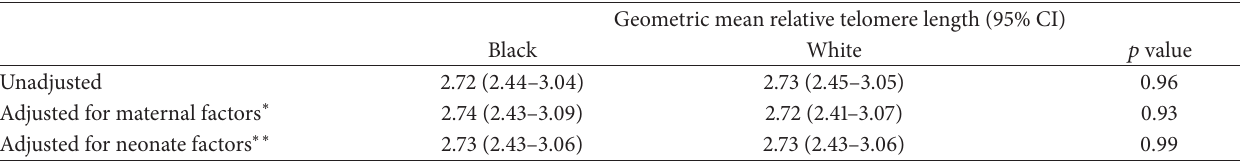
Table 4: Geometric mean telomere length in umbilical cord blood leukocytes by race, males in the hormones in umbilical cord blood study.